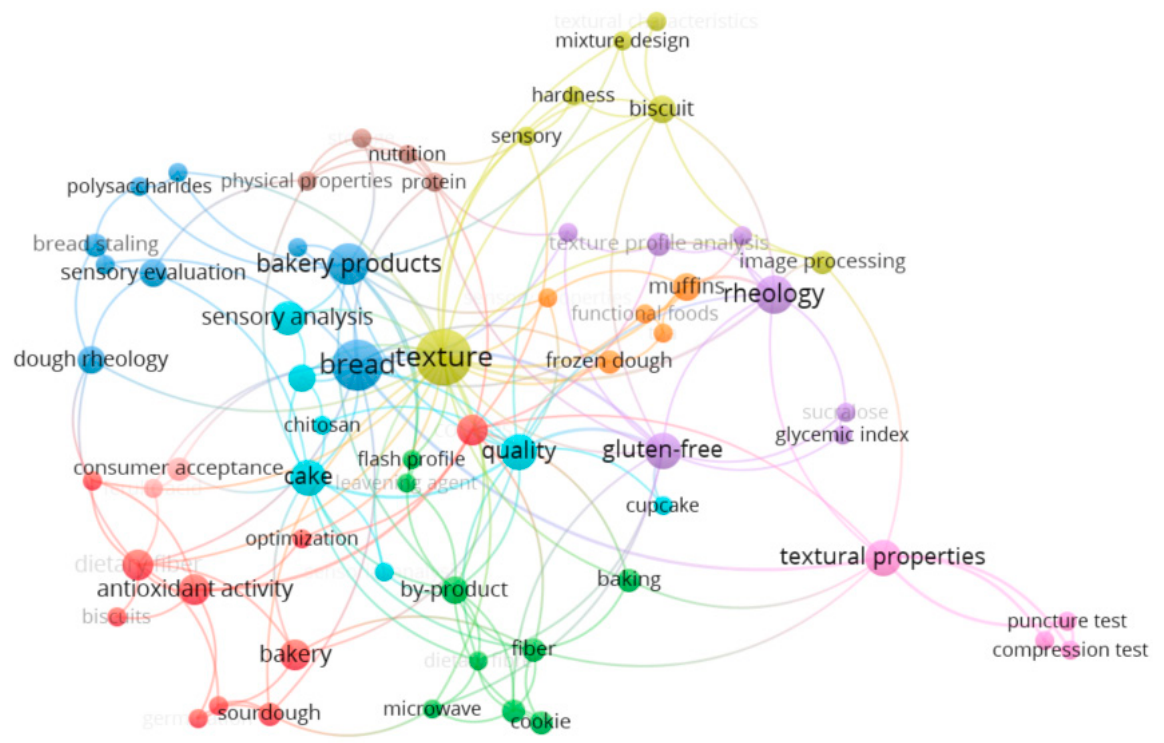
Figure 2. Analysis of co-occurrence links between keywords, considering those that occurred at least